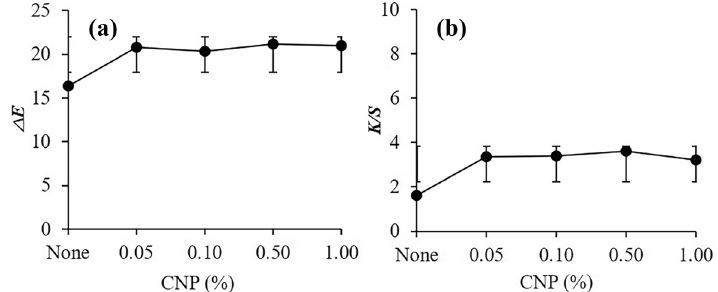
Fig. 1 Color difference and depth of cotton dyed with Euphorbia by different concentrations of cellulose nanoparticles (CNP). ( a ) △ E (colordifference), ( b ) K/S value (color